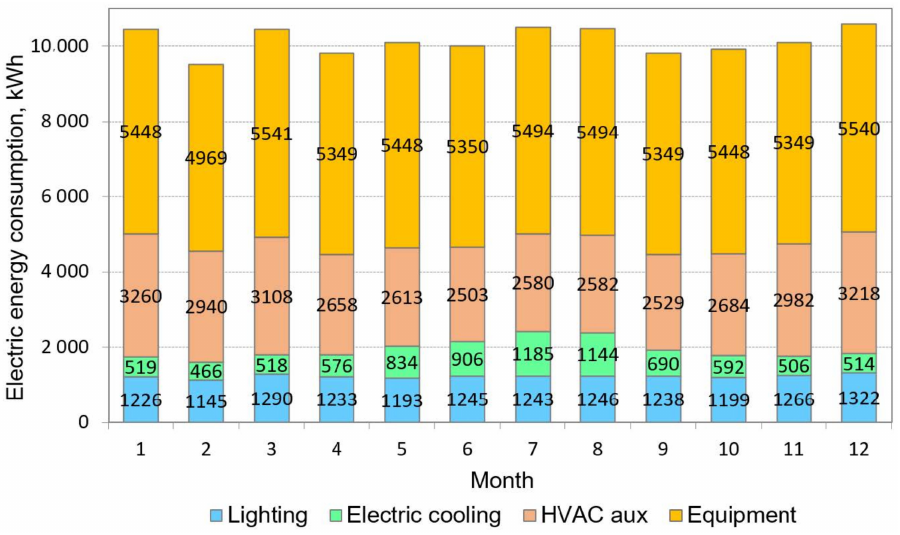
Figure 10. Monthly electric energy consumption in the CEEE’s